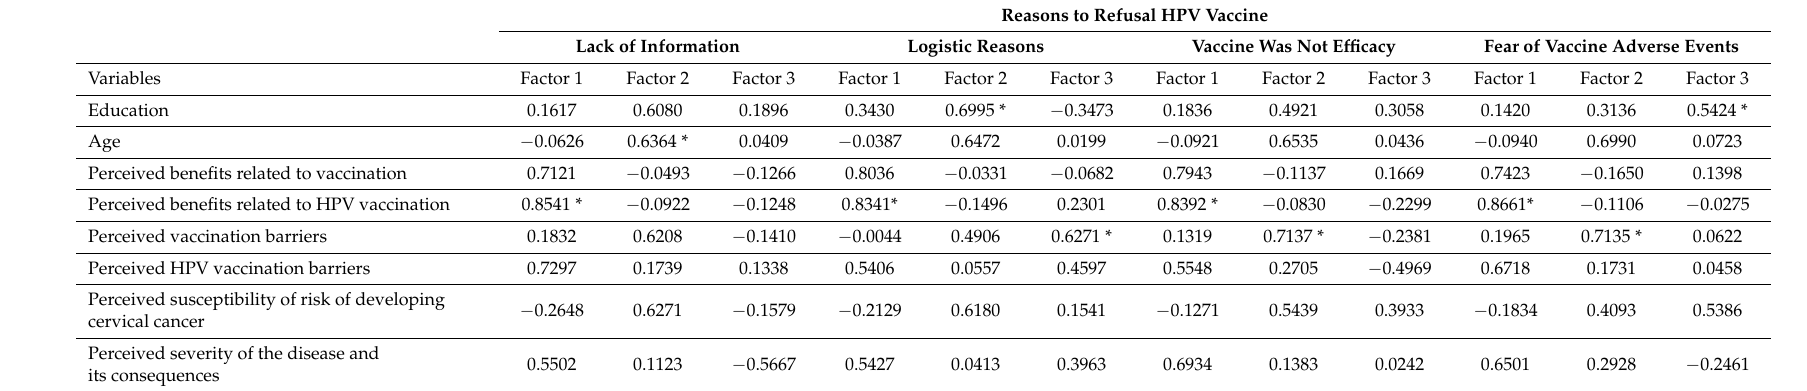
Table 4. Factor analysis of reasons to refusal HPV